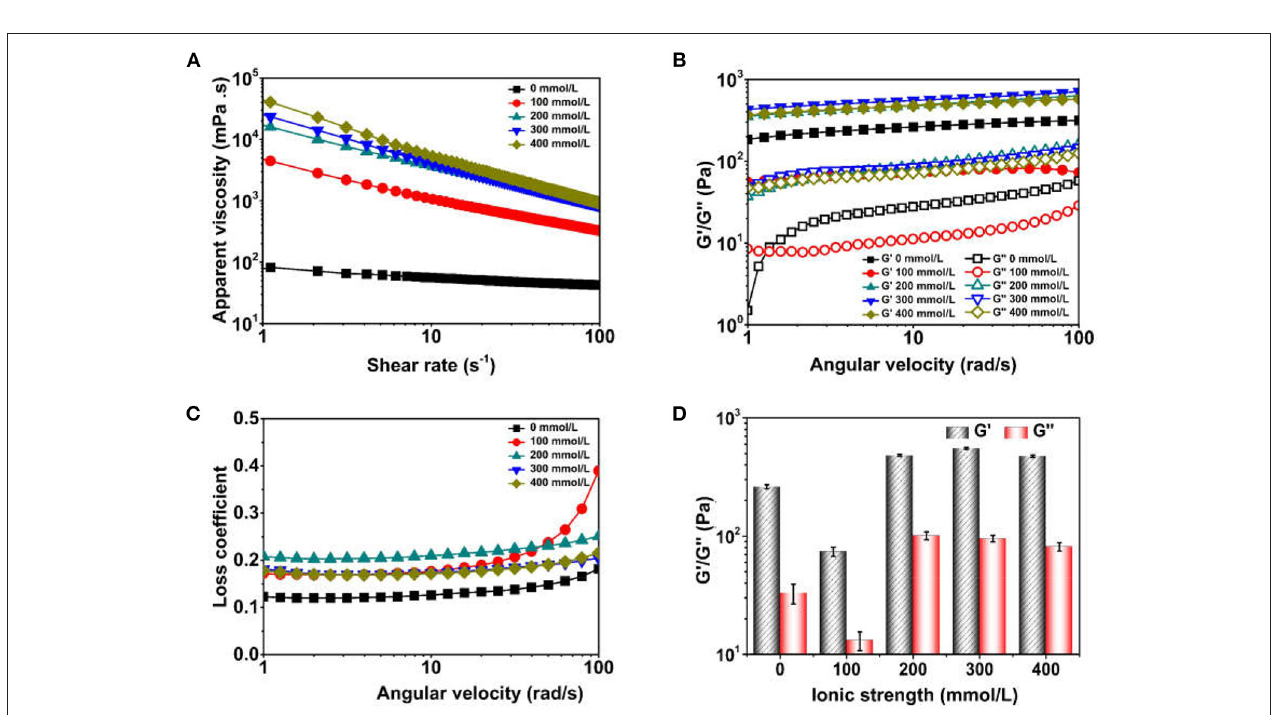
FIGURE 5 | Apparent viscosity and viscoelastic parameter of Pickering emulsions by tea water-insoluble protein nanoparticles under different ionic strengths [ (A) apparent viscosity; (B) G’/G”; (C) Loss coefficient; (D) G’/G” at 10 rad/s].